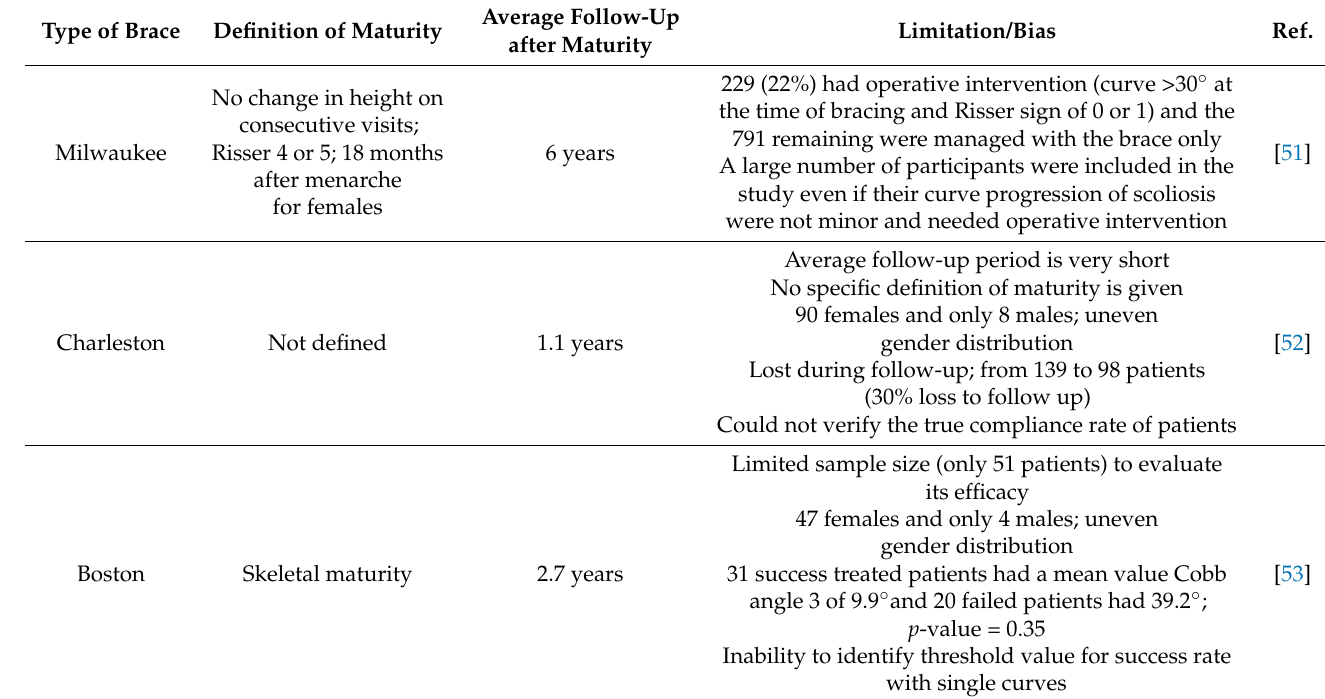
Table 4. Limitations, length follow-up, and biases of brace